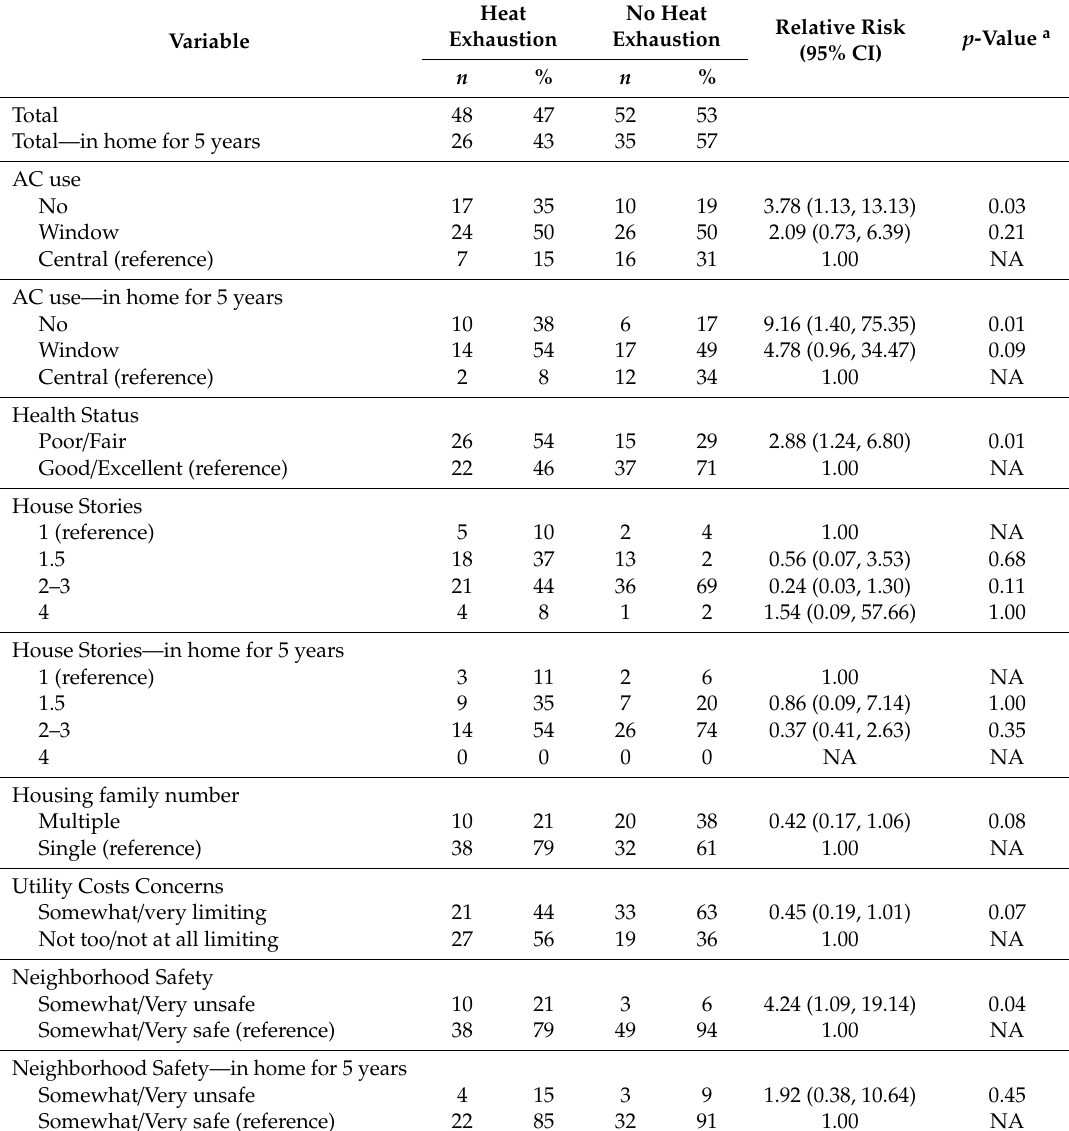
Table 1. Counts, means, and relative risks of experiencing vs. not experiencing heat exhaustion in the previous five years by demographic, housing, and neighborhood characteristics for all study participants who knew whether they had experienced heat exhaustion in the previous 5 years ( n = 100) and for those residing in their home in the previous 5 years ( n = 61) in Detroit, MI, 2016–2017.